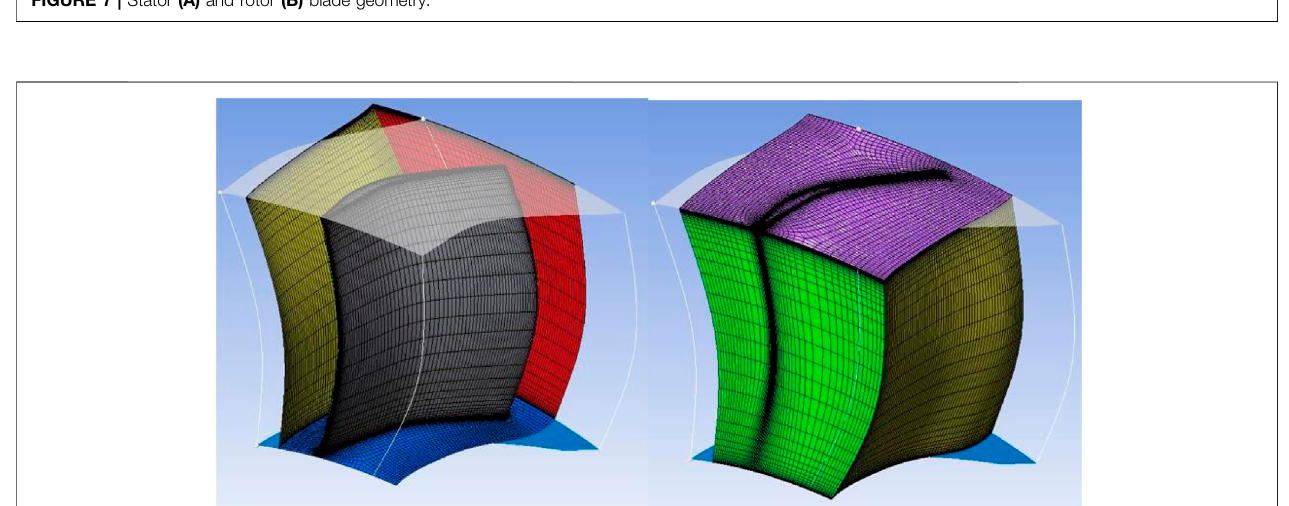
FIGURE 7 | Stator (A) and rotor (B) blade geometry.